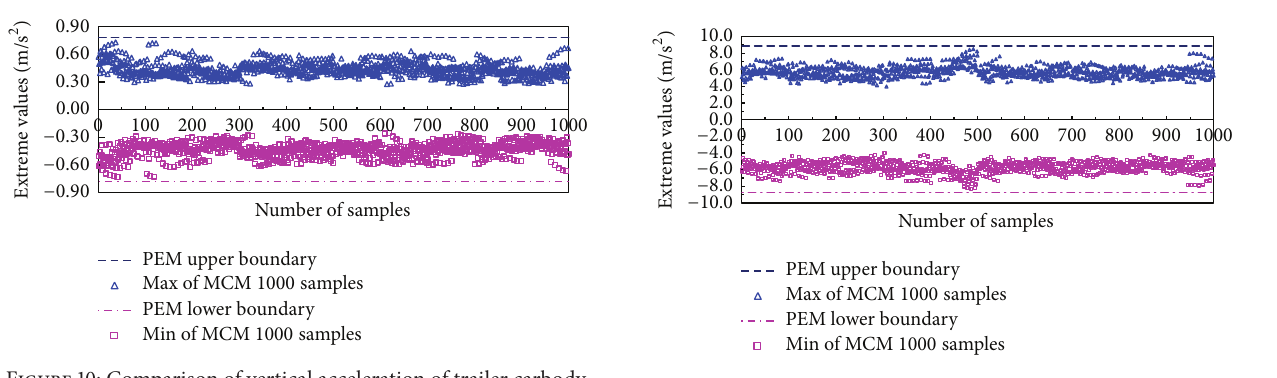
Figure 12: Comparison of rear bogie vertical acceleration of trailer